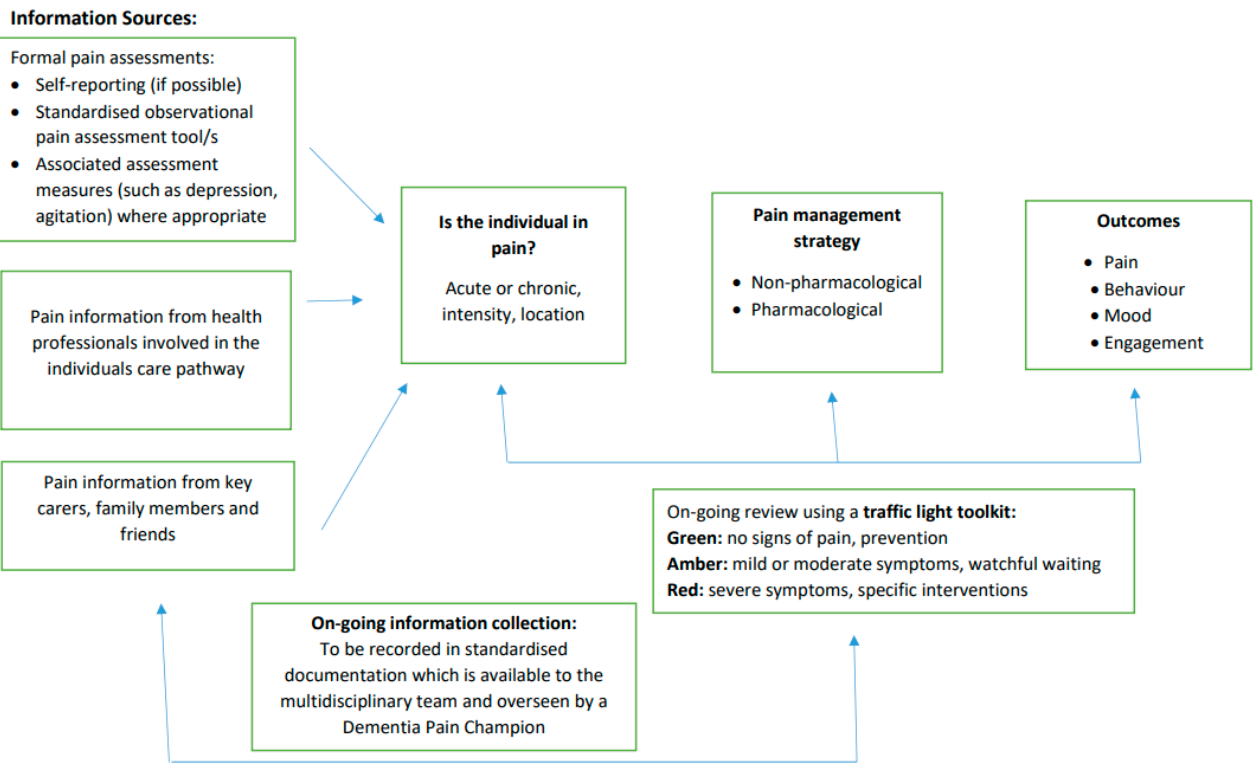
Figure 3. Pain Decision-making Model. Advanced dementia in the care home